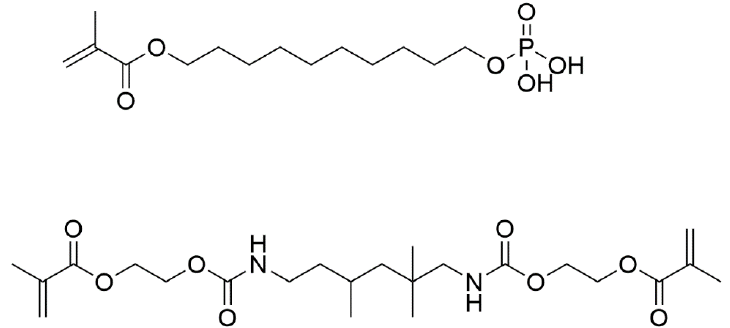
Figure 1. Chemical structures of MDP ( top ) and UDMA ( bottom ).